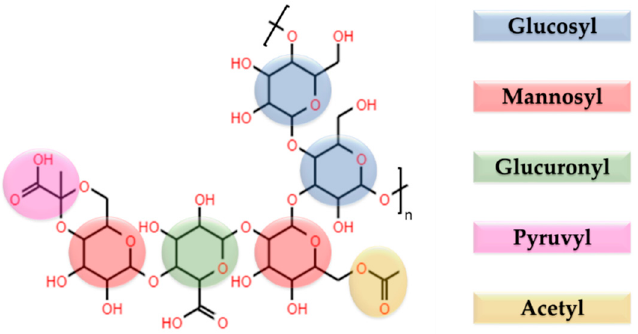
Figure 4. Schematic representation of the chemical structure of xanthan gum.